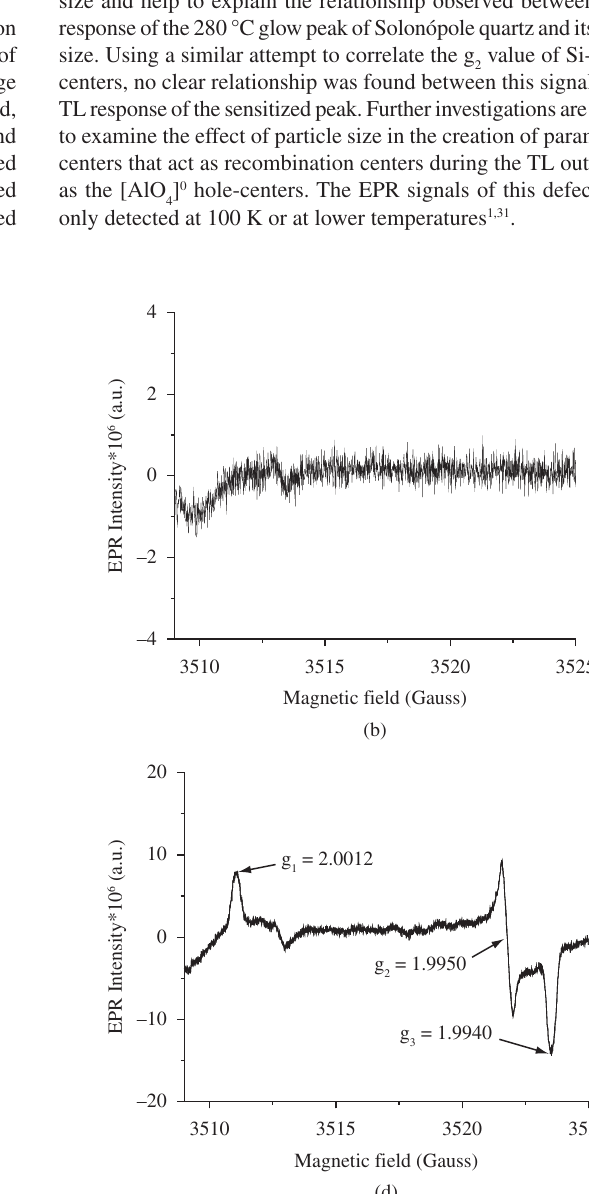
= 138 µ m obtained at room temperature in non-sensitized (a, b) and sensitized (c, d) m